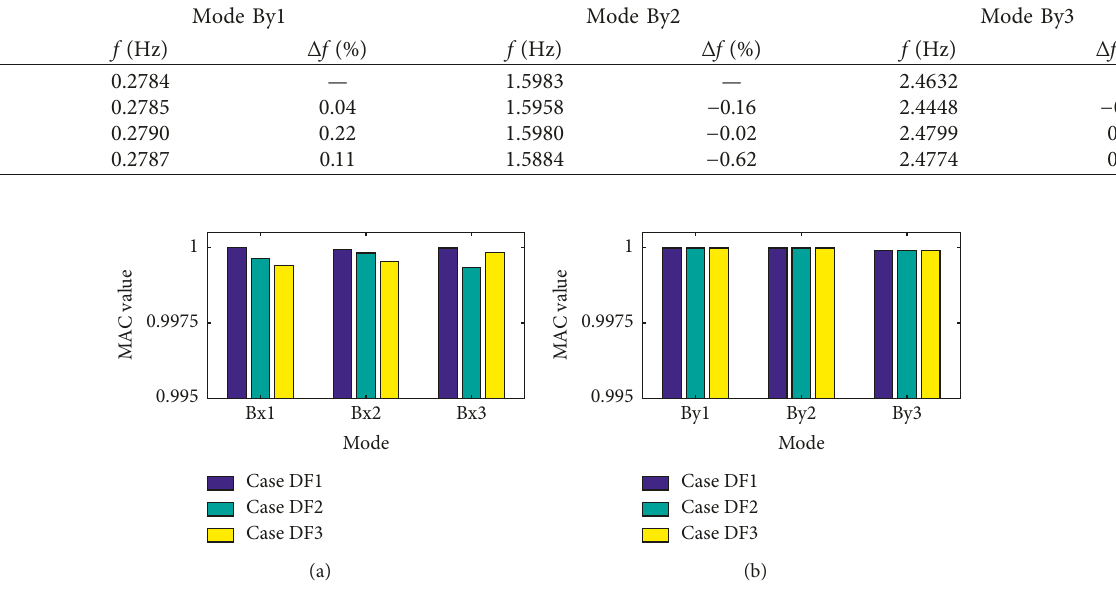
Figure 19: Modal assurance criterion (MAC) of mode shapes: damage type 3. (a) Along-wave modes. (b) Across-wave